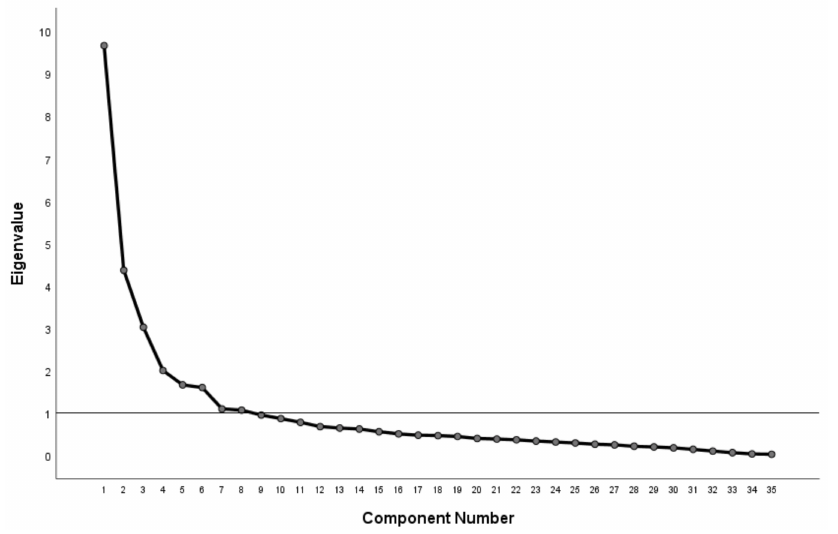
Figure 2. The components’ eigenvalues. Table 2. The resulting 8-factor structure for the SF-36 assessment for stroke survivors with physical